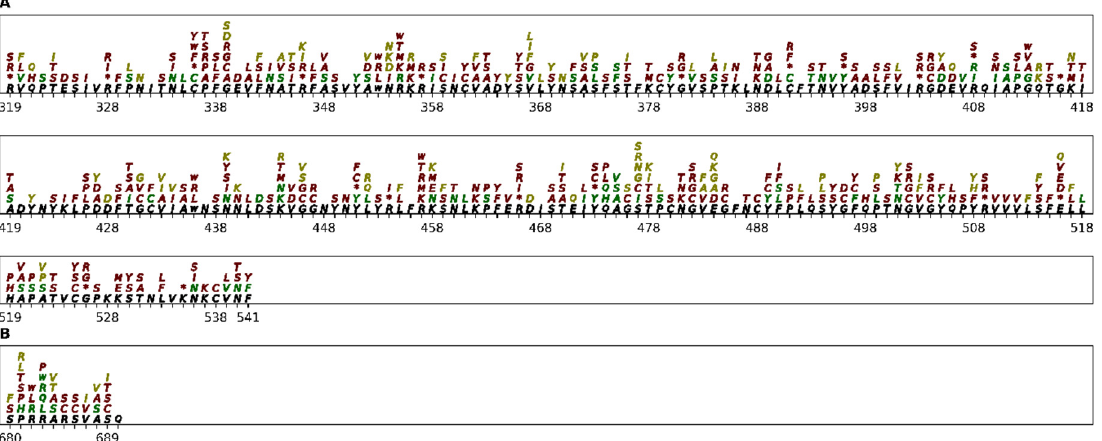
Figure 6. Comparison between AA changes predicted by our model and changes observed up until January 2022 from the RBD and furin cleavage site of the spike protein. The sequence from the RBD ( A ) and furin cleavage site ( B ) from the spike protein is shown in black. The AA changes predicted by our model are stacked over the reference sequence. The true positives, false positives, and false negatives are shown in green, red, and dark yellow/gold. * represents a stop codon, and the same AA represents a synonymous mutation.